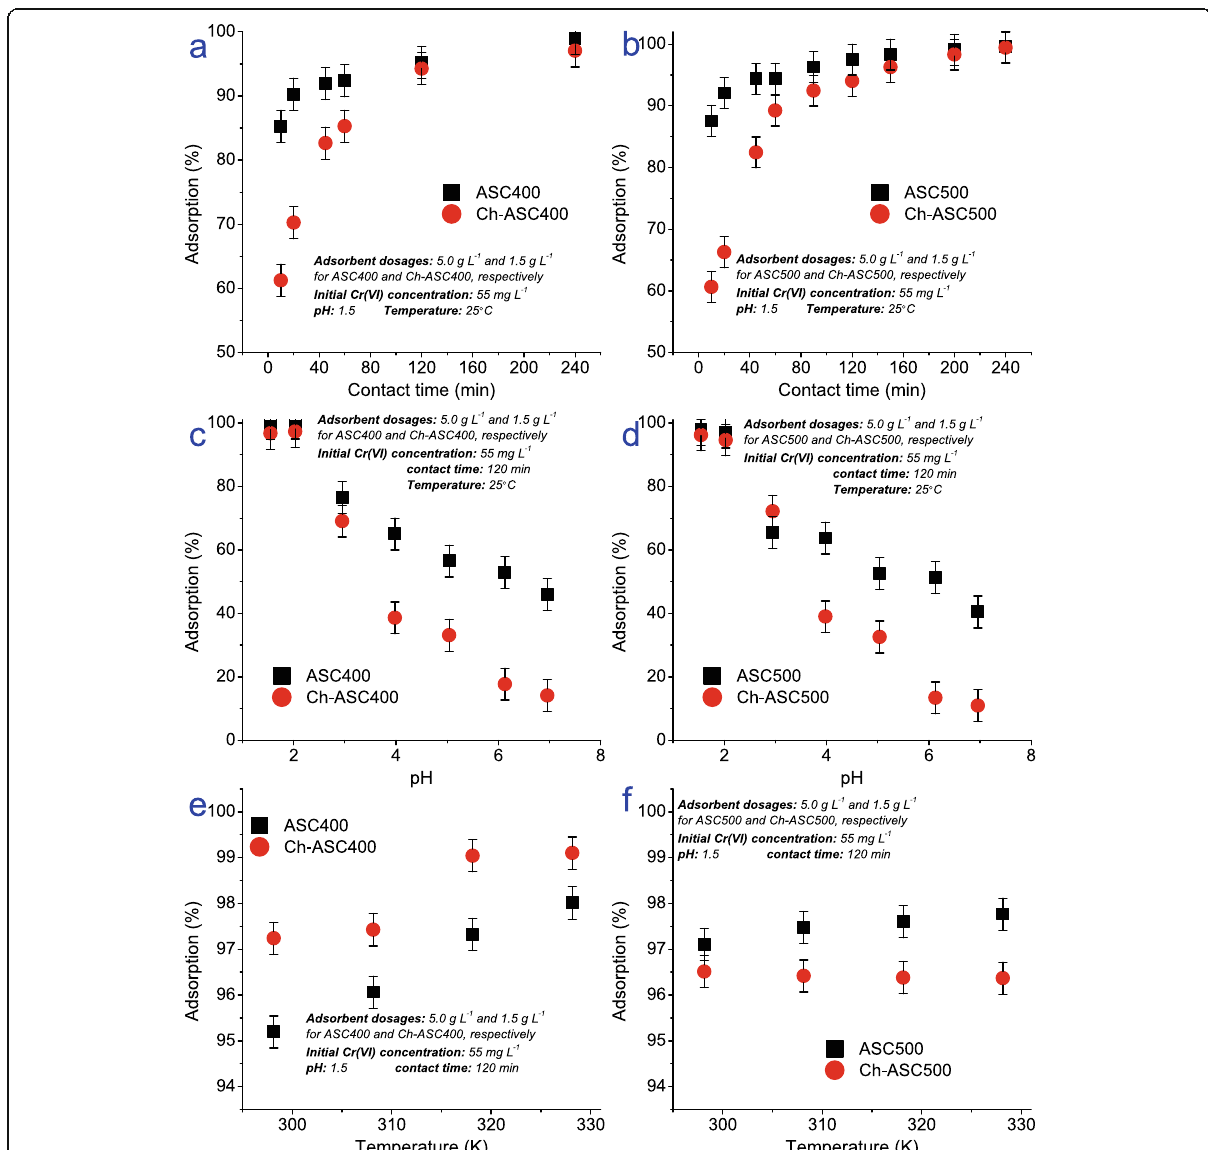
Fig. 9 Effect of contact time ( a and b ), pH ( c and d ), and temperature ( e and f ) on Cr(VI) adsorption: a , c , and e for ASC400 and Ch-ASC400; b , d , and f for ASC500 and